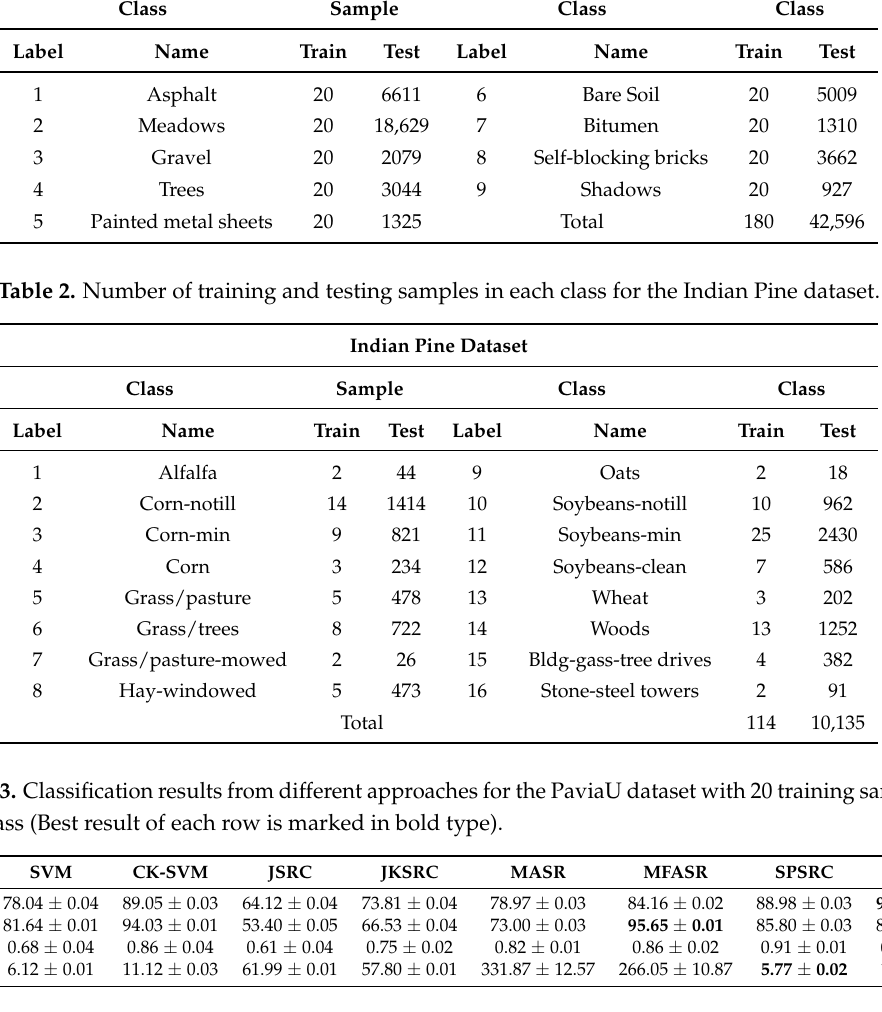
Table 4. Classification results from different approaches for the Indian Pine dataset with 1% training samples (Best result of each row is marked in bold